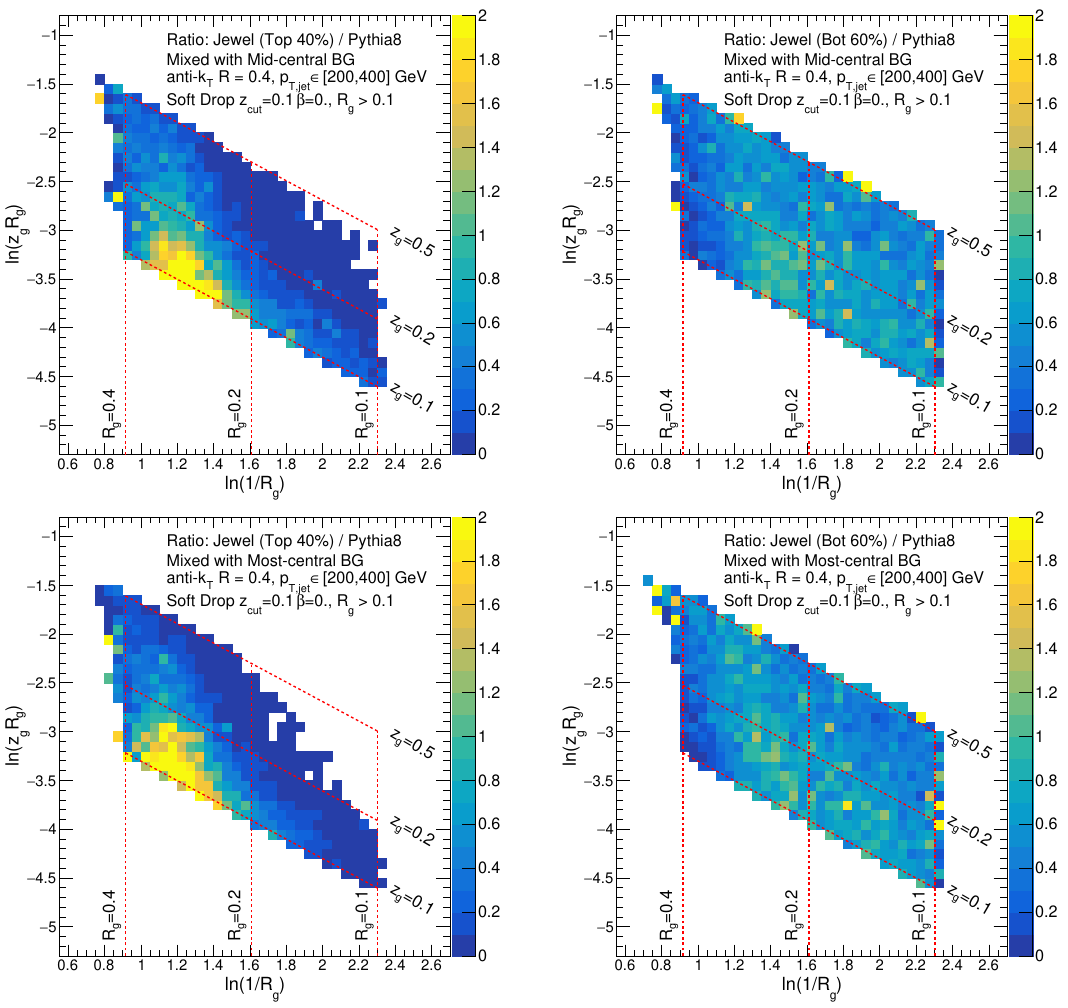
Figure 11 . Primary Lund plane density for the top 40% Jewel samples (left) and the bottom 60% Jewel samples (right). Plots for the mid-central and the most-central event mixing scenarios are shown in the upper and lower panels,